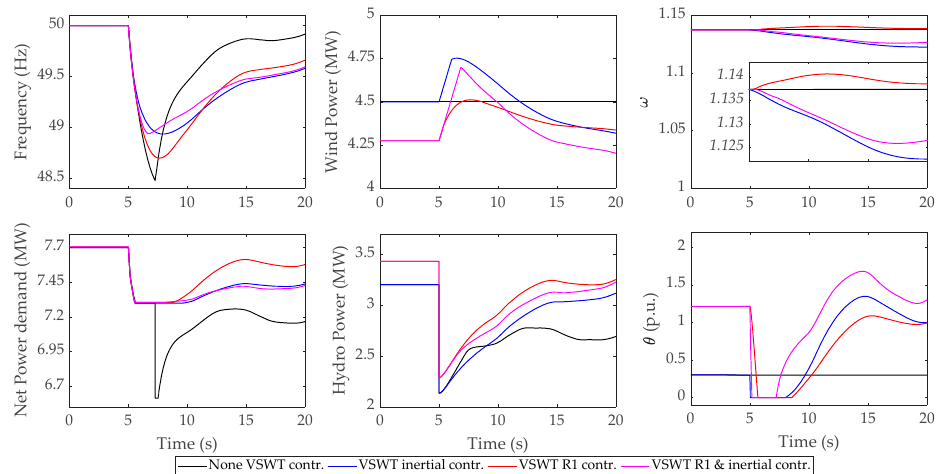
Figure 9. Dynamic system response considering different VSWT contributions when the “biggest operating unit” outage takes place.